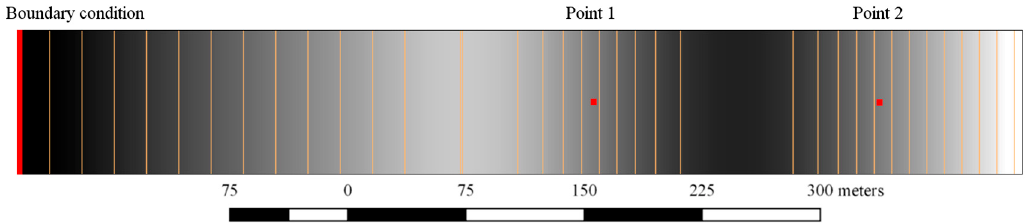
Figure 2. Simulated domain for Test 1. White areas represent high terrain elevation. To the left, there is an inlet boundary condition. In red, the measurement points.